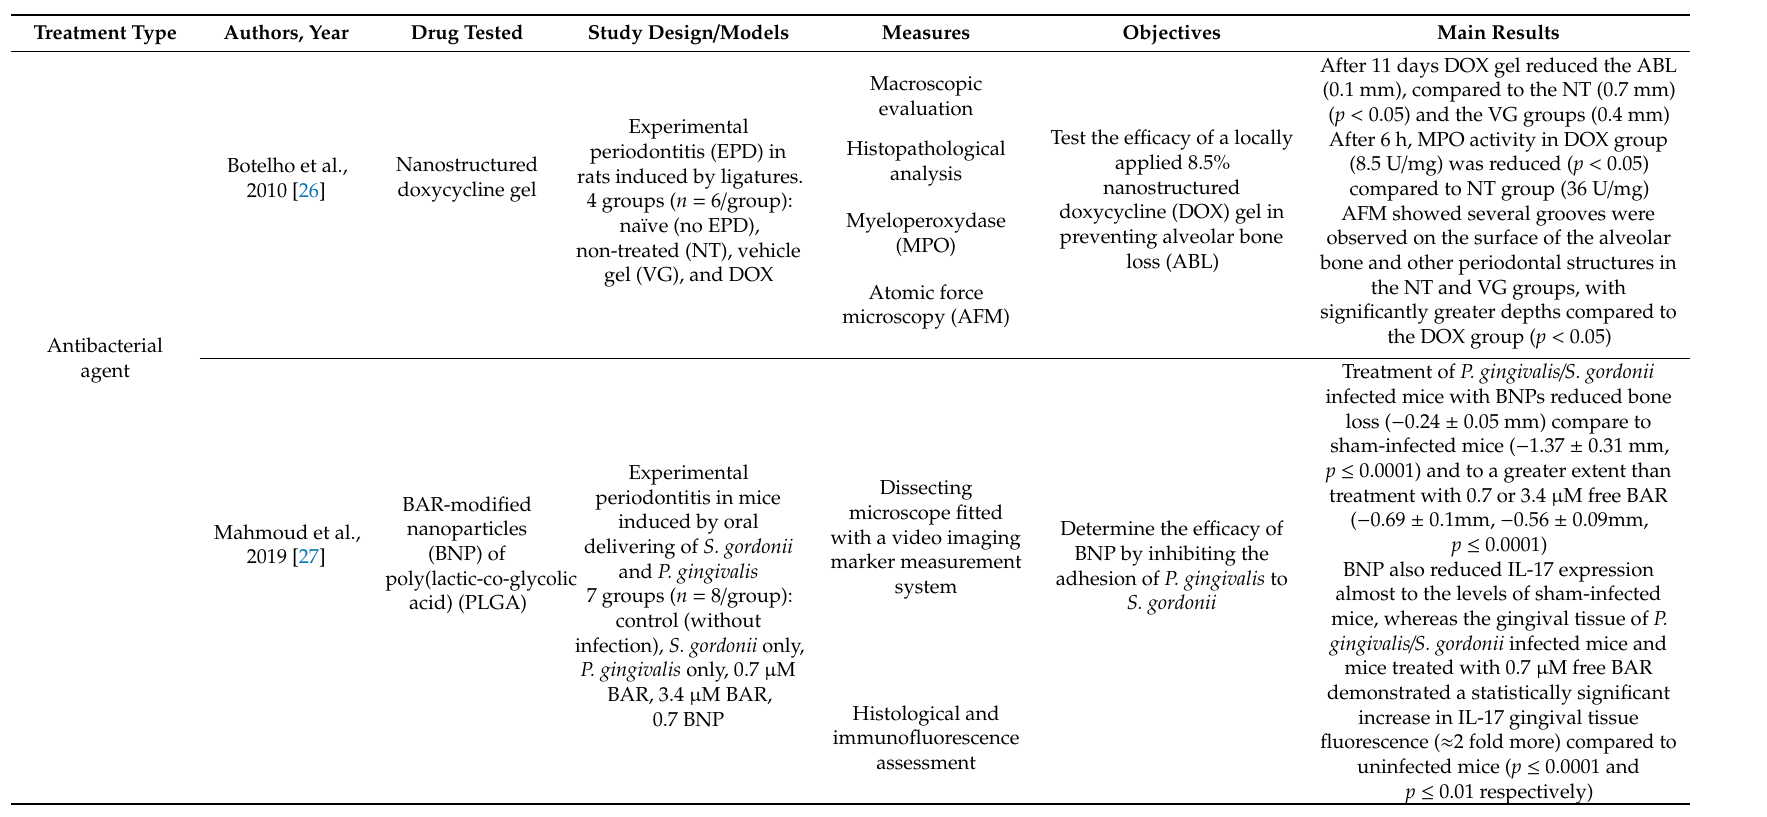
Table 1. The included studies: main characteristics, objectives and